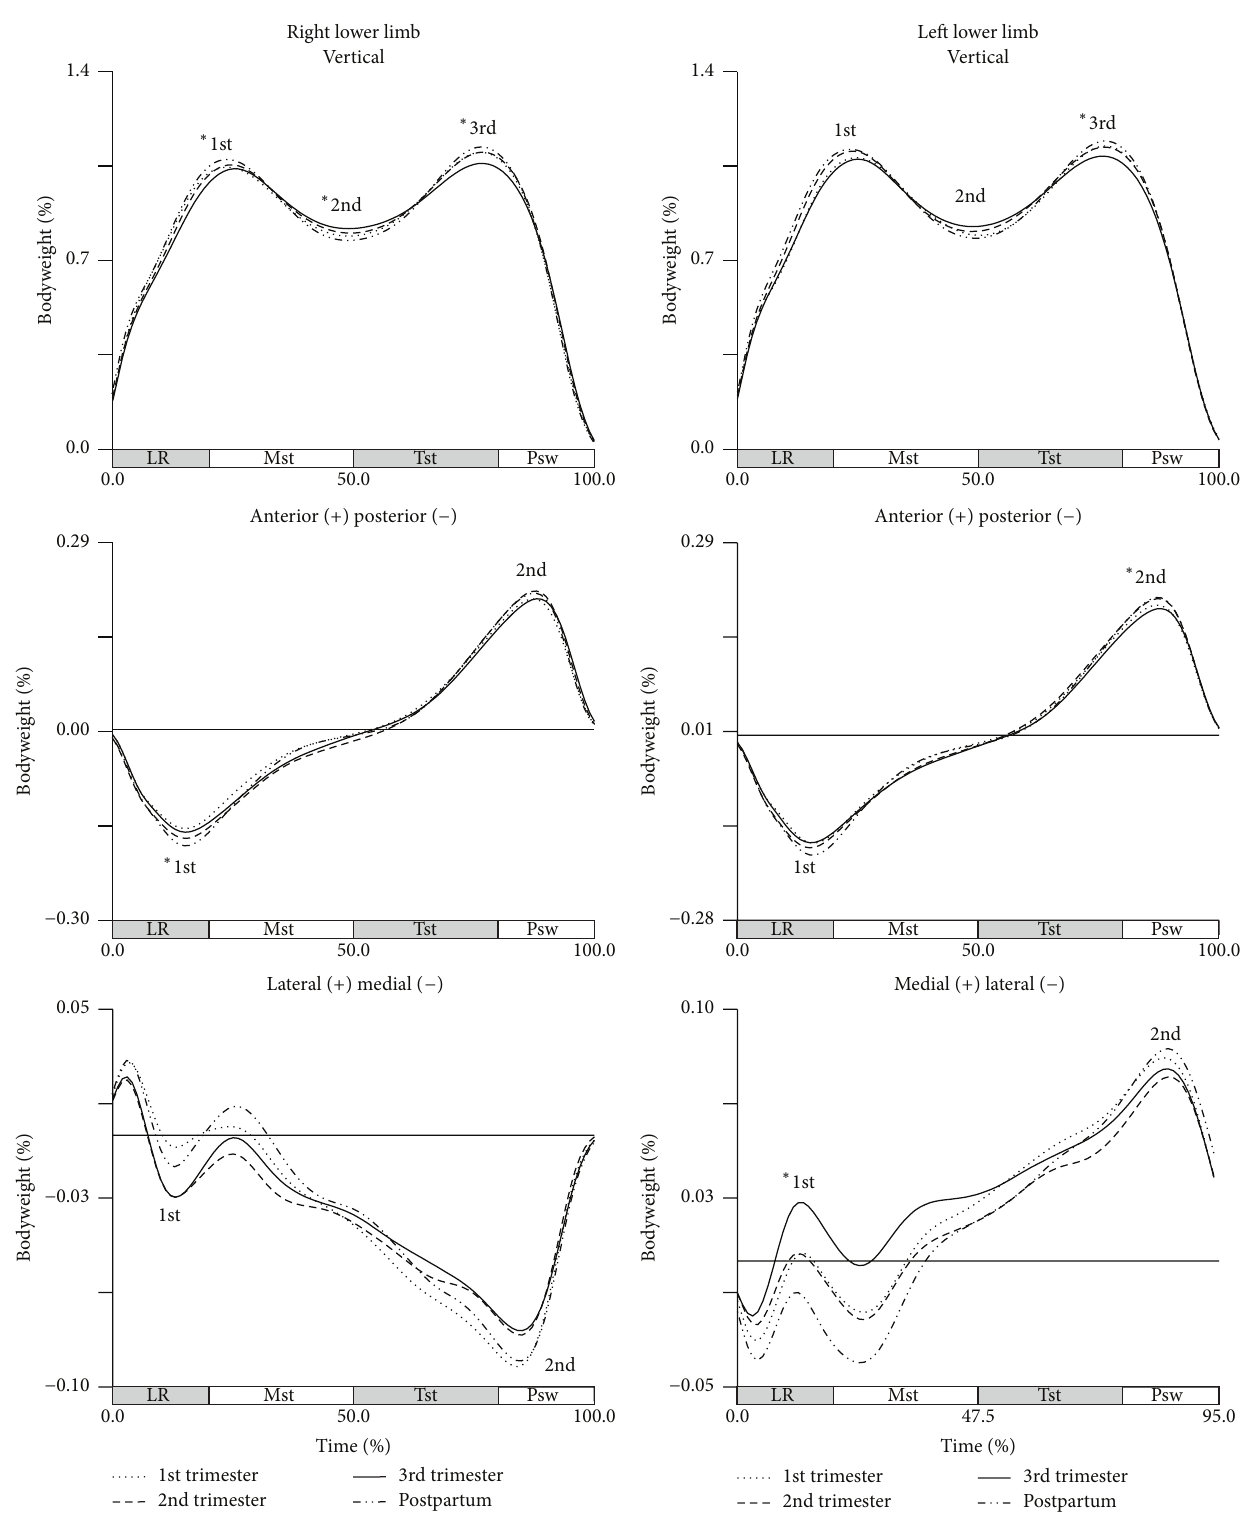
Figure 1: Mean values of ground reaction forces of each group (in bodyweight). Each line represents the later stages of first (dotted line), second (dashed line), and third trimesters (solid line) and of postpartum period (dash-dot-dot line). Mean vertical, anterior-posterior, and medial-lateral components of GRF, for right and left lower limbs. The curve peaks are indicated by numbers: 1st, 2nd, and 3rd, and ( ∗ ) points the significant